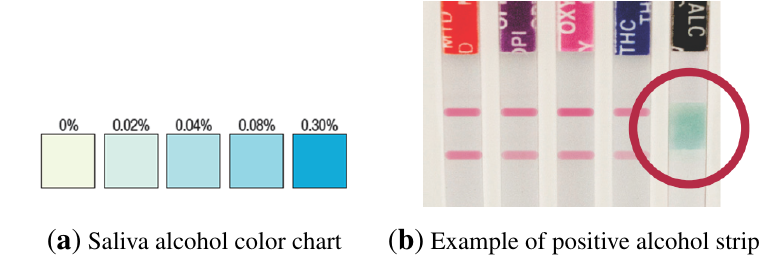
Figure 2. ( a ) Color chart to obtain the relative blood alcohol concentration by comparison with the colored area in the test strip; ( b ) test sample including an alcohol